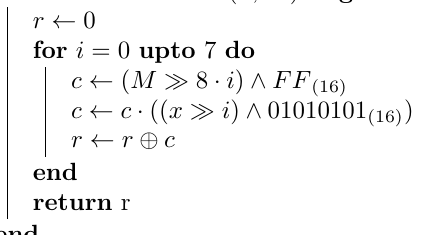
Algorithm 23: FieldAff’ : apply packed F